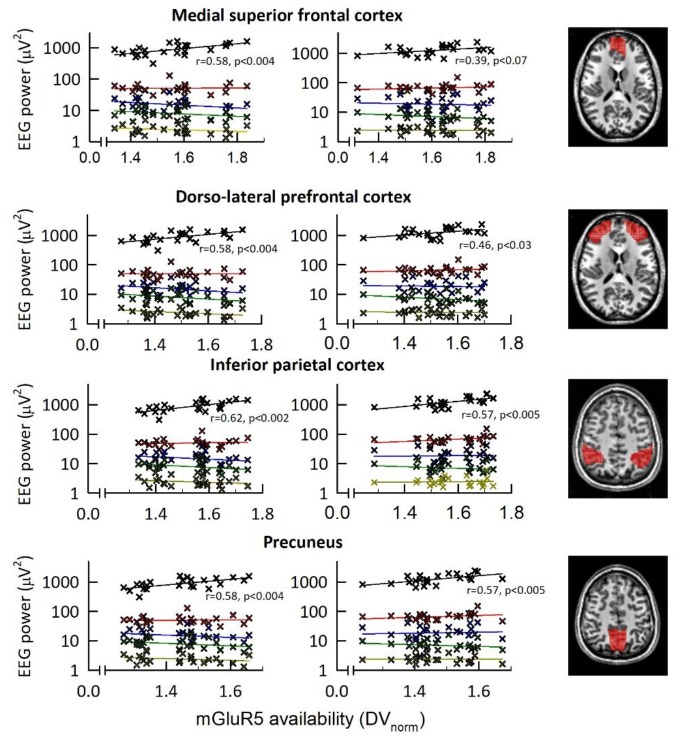
Correlations between EEG power bands and regional mGluR5 availability.EEG power (C3M2 derivation) plotted on a logarithmic scale for delta (0.5–4.5 Hz; black), theta (4–8 Hz; red), alpha (8–12 Hz; blue), sigma (12–15 Hz; green) and beta (15–20 Hz; yellow) ranges in the first NREM sleep episode of sleep control (left) and sleep deprivation (middle) conditions. Spearman rank correlation coefficients (r) and p-values of significant correlations are presented. Regions and right column are the same as in Figure 3.